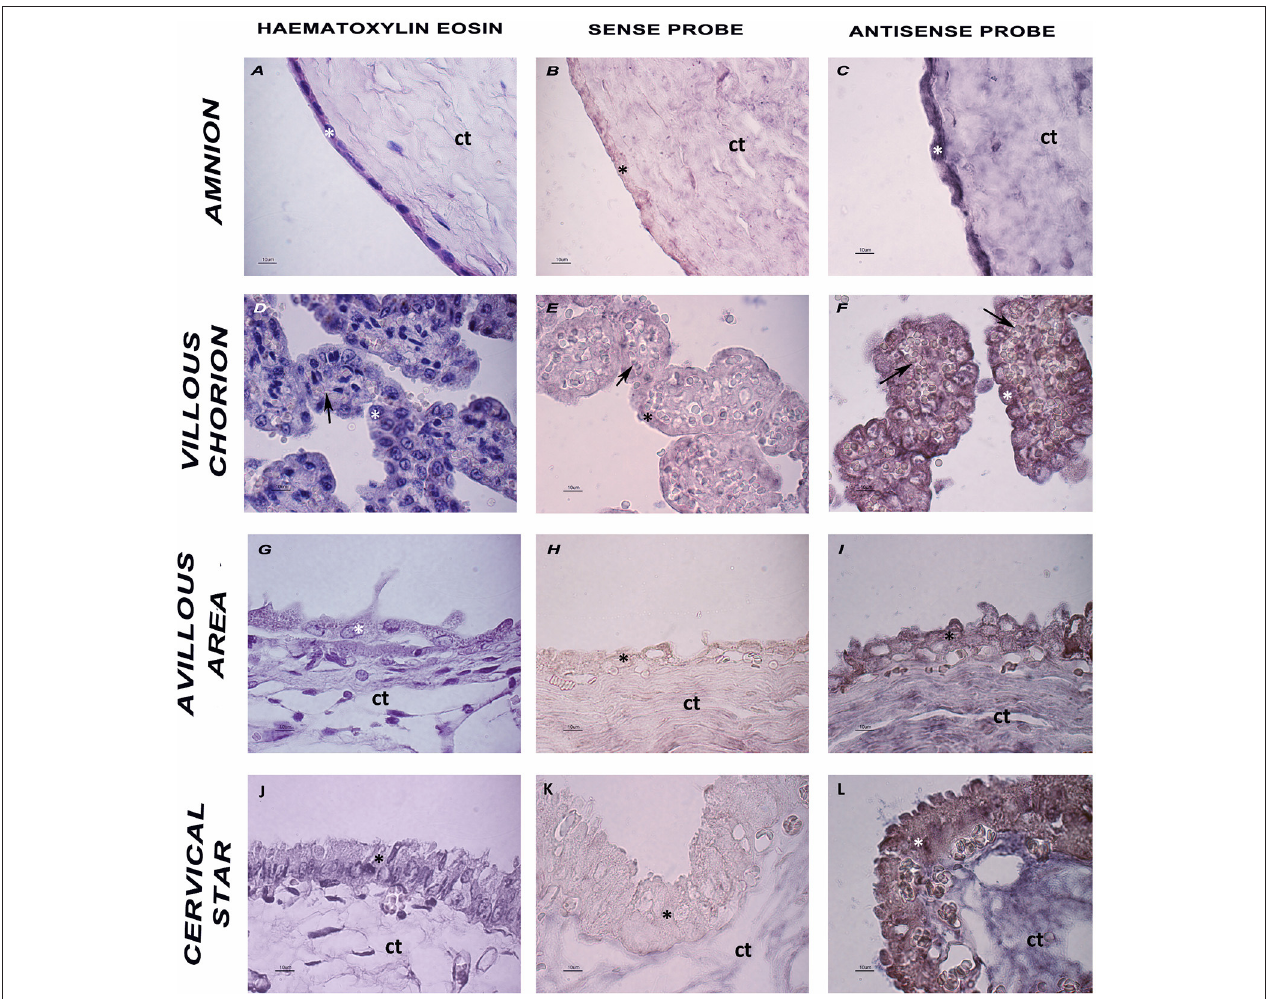
FIGURE 3 | Histology and ISH of placental sections. (A,D,G,J) Hematoxylin and eosin staining of the four tested areas. (B,E,H,K) ISH negative control, sense probe. (C,F,I,L) ISH-Purple staining indicates the presence of EqERV env detected by the antisense probe. Ct: connective tissue; asterisk: cell layer lining the chorionic surface and the amnion; arrow: blood vessels. Representative images at high magnification are shown (scale bar 10